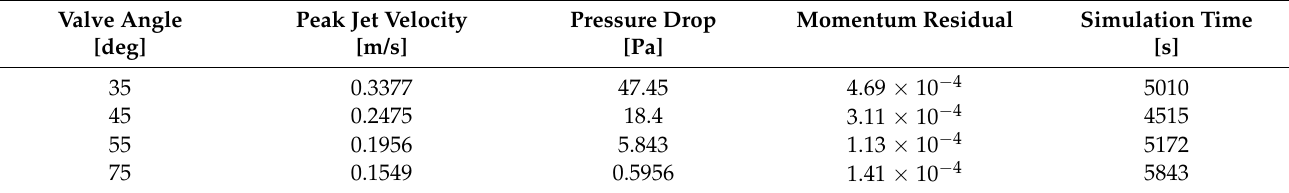
Table 4. Simulation Cases: PINN.